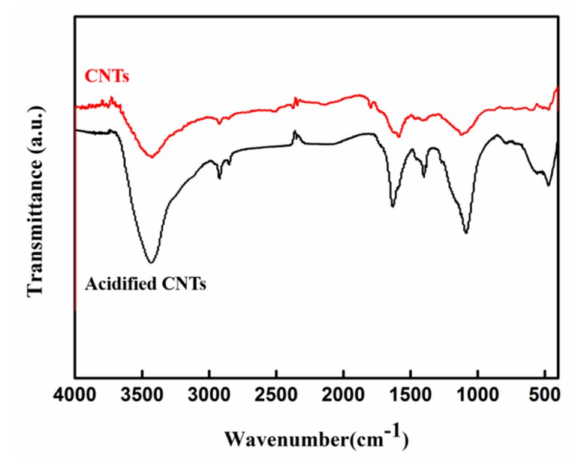
Figure 1. FT-IR patterns of CNTs before and after acidification.